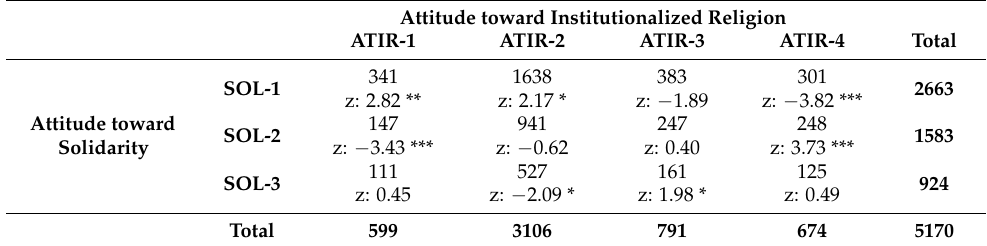
Table 9. Relationship between the attitude toward institutionalized religion (ATIR) and solidarity (SOL). Attitude toward Institutionalized Religion ATIR-1 ATIR-2 ATIR-3 ATIR-4 Total SOL-1 Attitude toward Solidarity